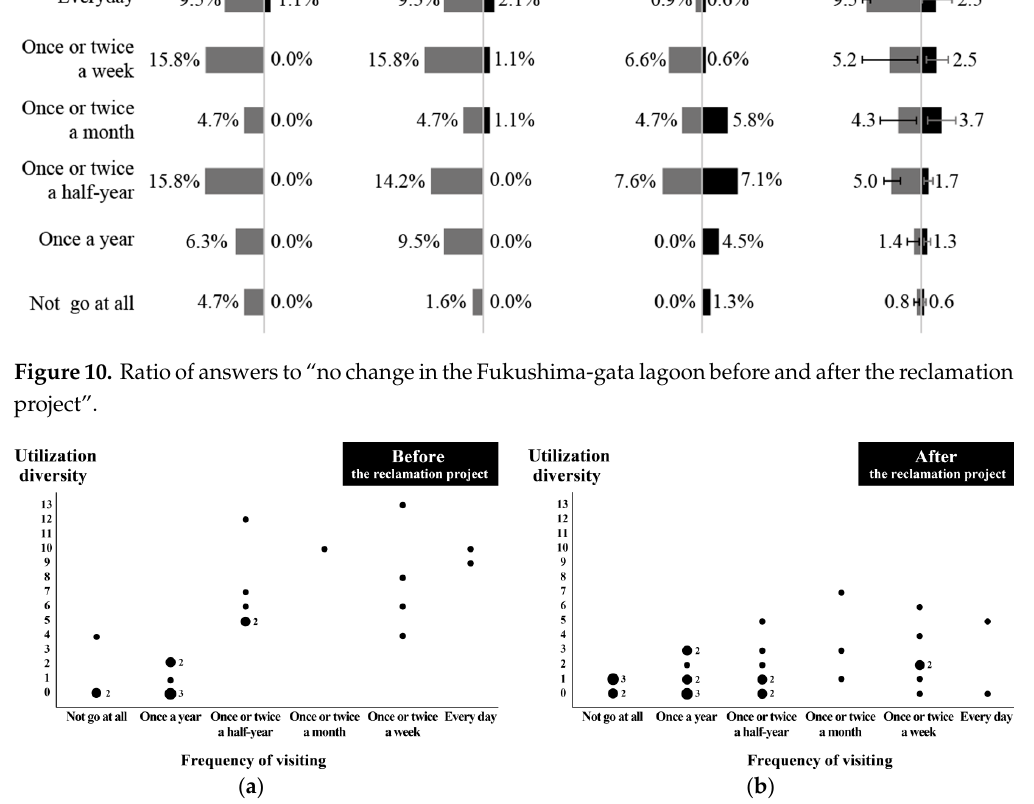
Figure 11. Frequency of visits after the reclamation project and utilization diversity before and after the reclamation project. ( a ): utilization diversity before the reclamation project; (b) : utilization diversity after the reclamation project.